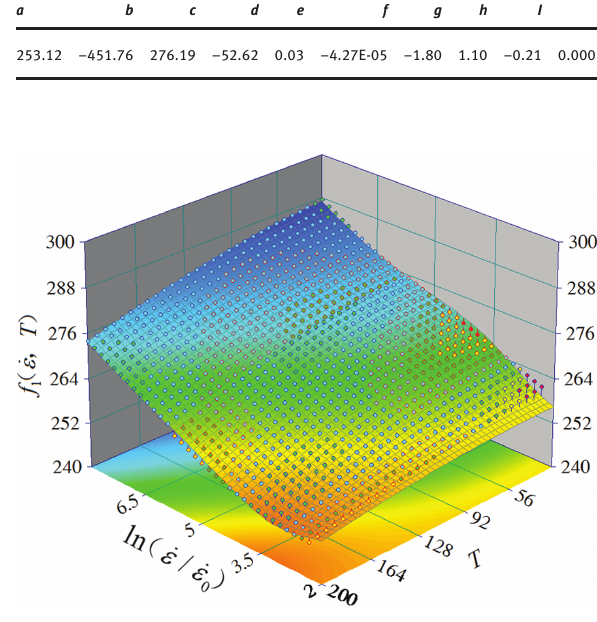
Figure 15: Fitting surface of strength at low temperatures under the ε =